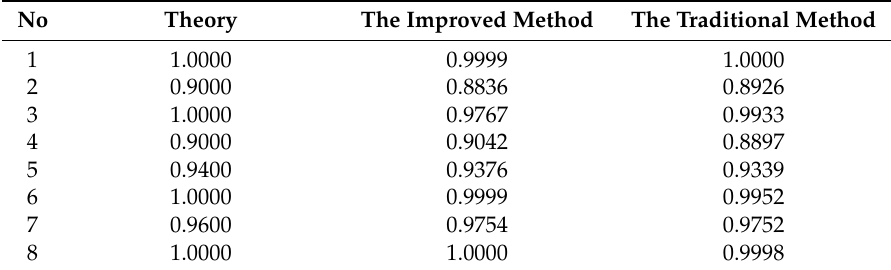
Table 4. Damage identification results with multiple smaller damages.